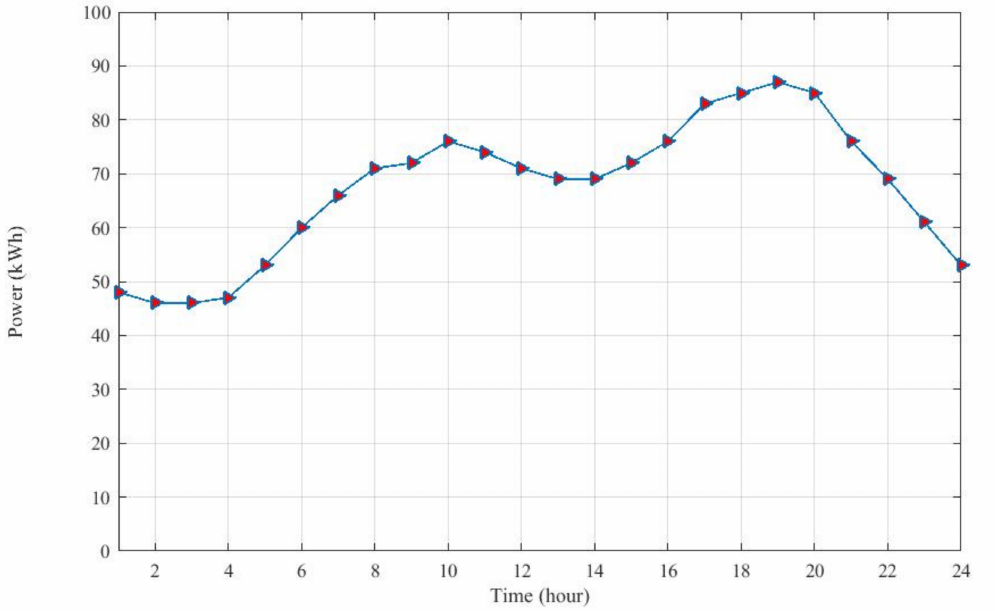
Figure 7. Forecasting load demand.